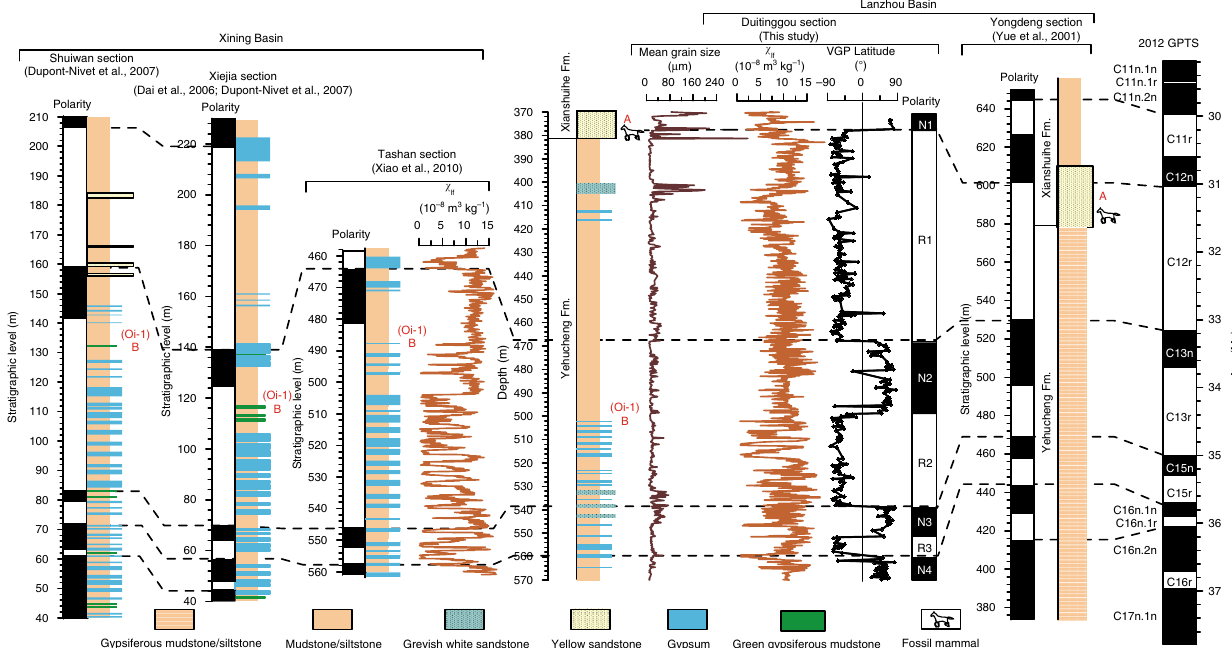
Fig. 2 Regional lithostratigraphic and magnetostratigraphic correlations. Lithostratigraphy and magnetostratigraphy of the Duitinggou and Yongdeng 36 sections in the Lanzhou Basin are compared with those of the Shuiwan 9 , Tashan 16 , and Xiejia 9,40 sections in the Xining Basin, and correlate with the 2012 geomagnetic polarity time scale (GPTS) 41 . Mean grain size and magnetic susceptibility ( χ lf ) records for the Duitinggou section and the Tashan χ lf record 16 are also shown. The uppermost 14 virtual geomagnetic pole (VGP) latitudes (open circles) for the Duitinggou section are from the bottom of the Xianshuihe Formation 37 . The yellow sand layer (layer A) that overlies the Yehucheng Formation at the Duitinggou and Yongdeng sections is a prominent marker layer across the Lanzhou Basin. The Oi-1 event coincides with the end of regular alternations of gypsum and red mudstone/siltstone beds at gypsum (or green gypsiferous mudstone) layer B, and with a decreased amplitude variability of χ lf at 100-kyr eccentricity periods. The Yehucheng Formation in the Yongdeng section was described only as gypsiferous mudstone/siltstone; more detailed lithological variations were not reported by Yue et al. 36